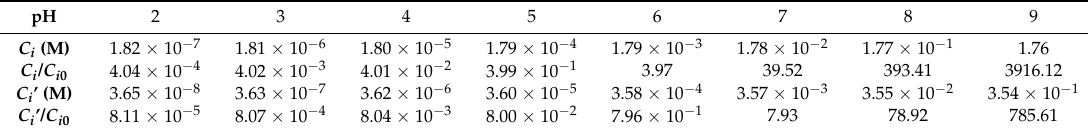
Table 2. The concentration of RNH 3+ in the sillimanite interface layer in the absence and presence of Ca 2+ ions. C i and C i ’ are the concentrations of RNH 3+ ions in the sillimanite interface layer without and with Ca 2+ ions, respectively.